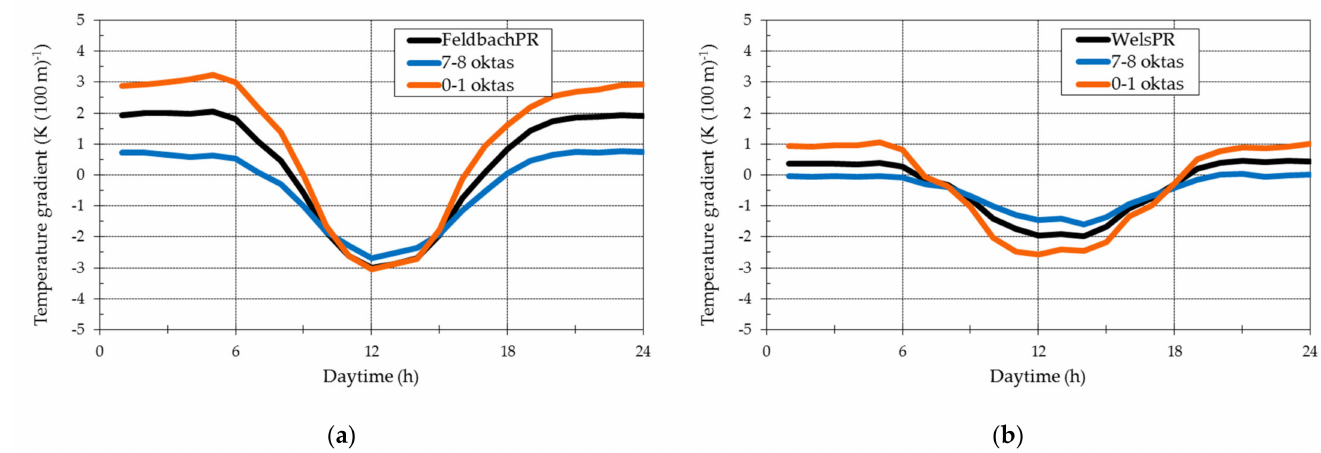
Figure 5. Annual mean of the daily course of the vertical temperature gradient (K (100 m) − 1 ) for low cloud cover (orange line), high cloud cover (blue line) and all data (black line) for ( a ) Feldbach and ( b ) Wels; PR—present (1981–2010).